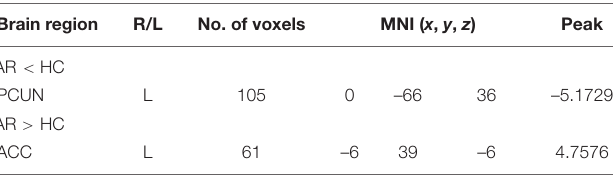
TABLE 2 | Two-sample t -test differences between AR patients and HCs using the ALFF method. Brain